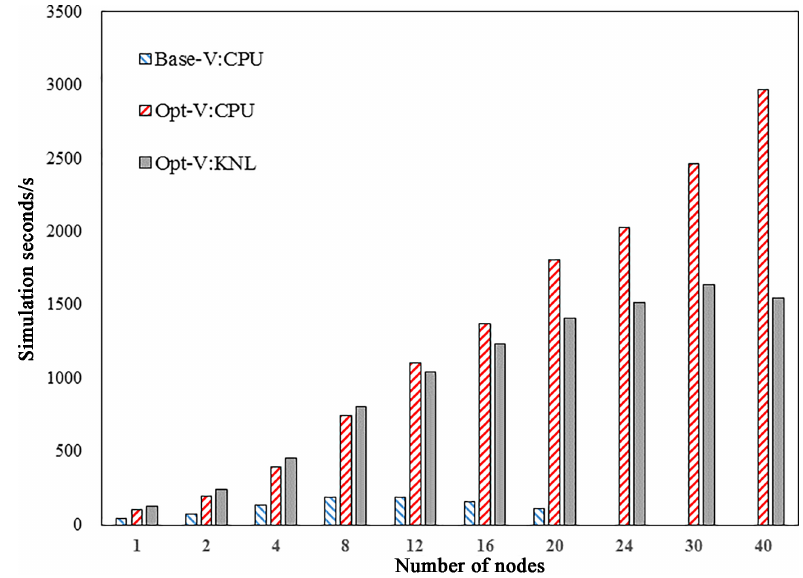
Figure 7. Simulation ability improved with increasing number of